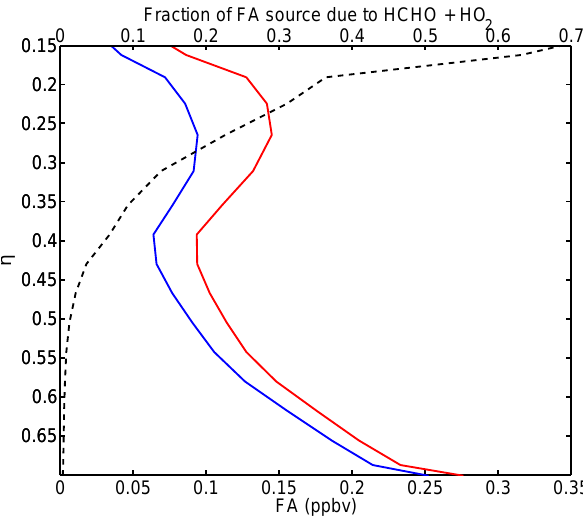
Fig. 12. Including a representation of HCHO + HO 2 chemistry in- creases FA in the upper troposphere by nearly 50% (red) compared to the reference run (blue). Such a source (black dashed line) would further amplify the high bias of the model with respect to ACE-FTS observations. Profile of FA at − 14 ◦ N, 60 ◦ W July